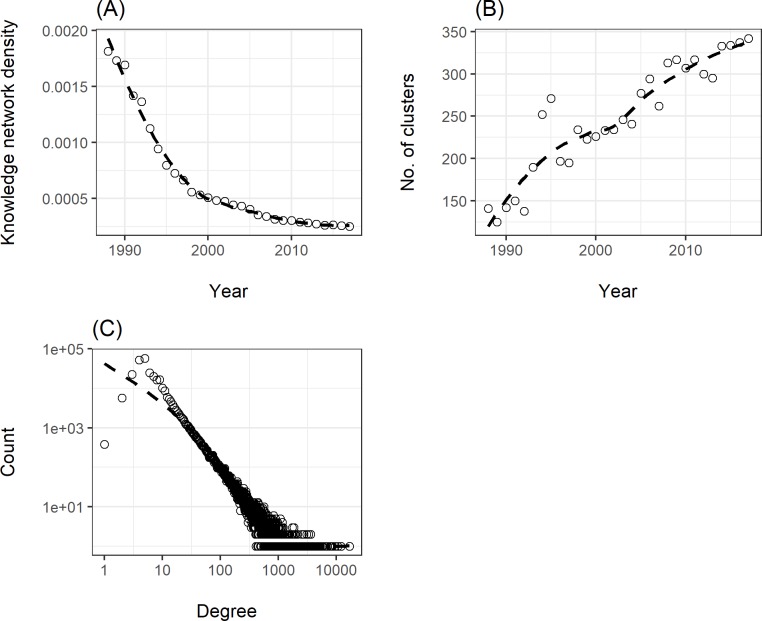
Basic property of the ecological knowledge network.(A) Temporal change of network density. (B) Degree distribution of the network. (C) Temporal change of network cluster number (both axes are logarithmic scaled). The dashed lines are calculated using LOESS (Local Regression) curve fitting.